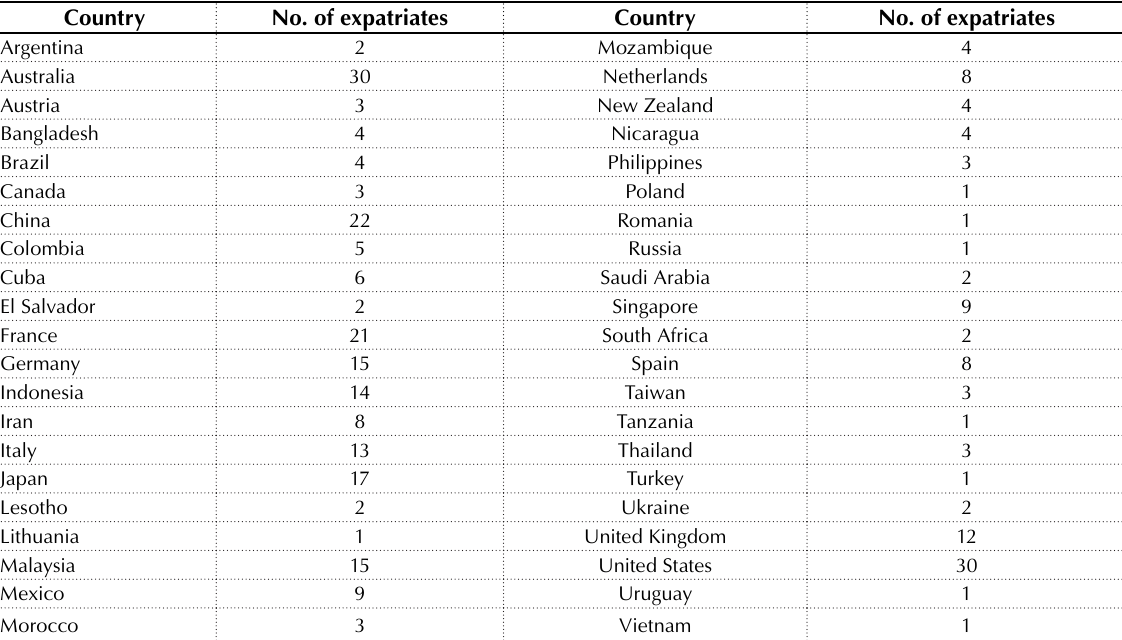
Table 1. Number of expatriates from each nationality